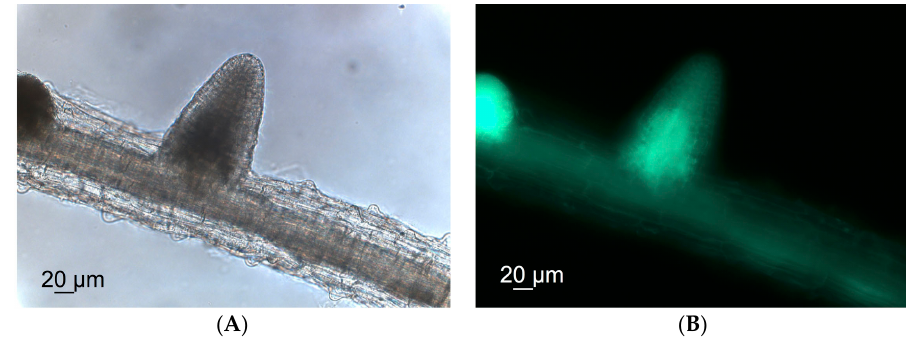
Figure 2. Microscopic image of an inoculated root with a GFP-labeled P. indica strain. ( A ) brightfield image; ( B ) fluorescence image.